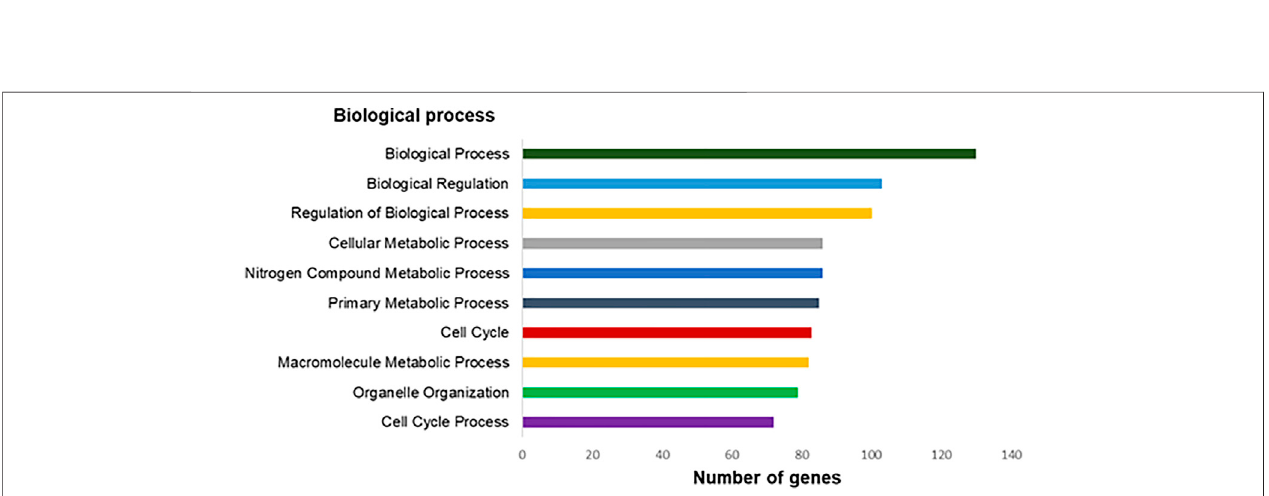
FIGURE 5 | Top-ranking of biological processes based on Gene Ontology annotation ( p < 0.05) related to differentially expressed genes in the exposed human salivary gland cells line to 2.5 µM of MeHg vs. nonexposed cells (MeHg vs. control).